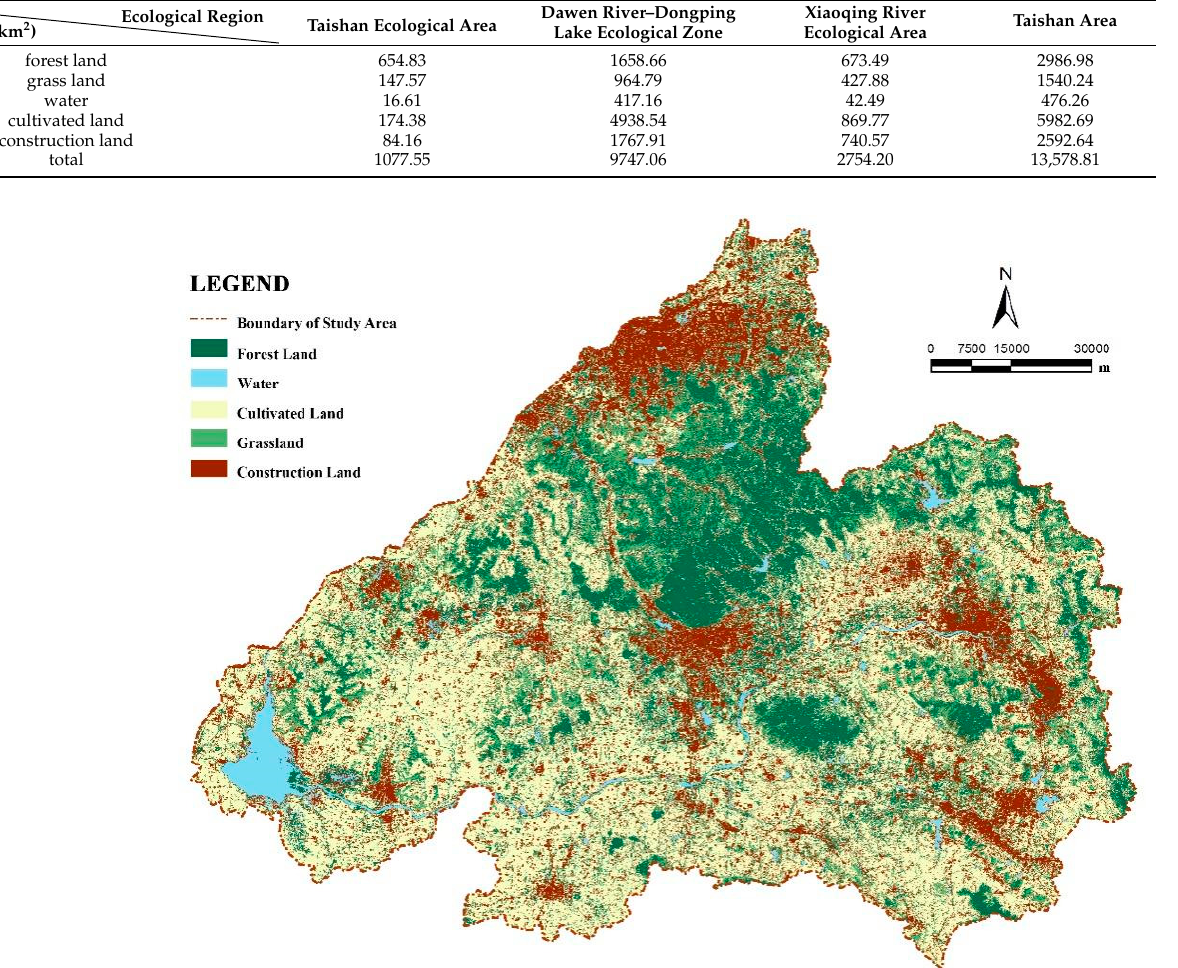
Table 2. Statisticsoflandusestatusofthelifecommunityofmountains–rivers–forests–farmlands–lakes–grasslands in Taishan area.